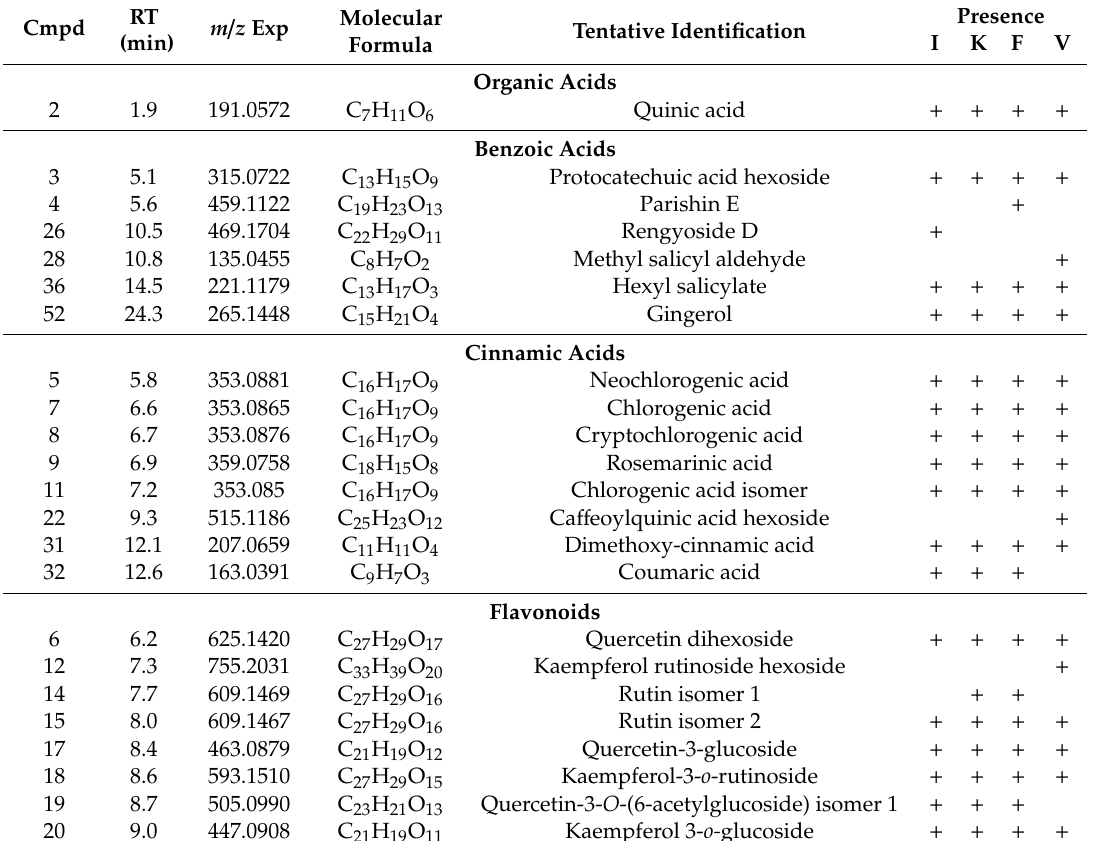
Table 2. Phytochemical composition of the analyzed M. alba